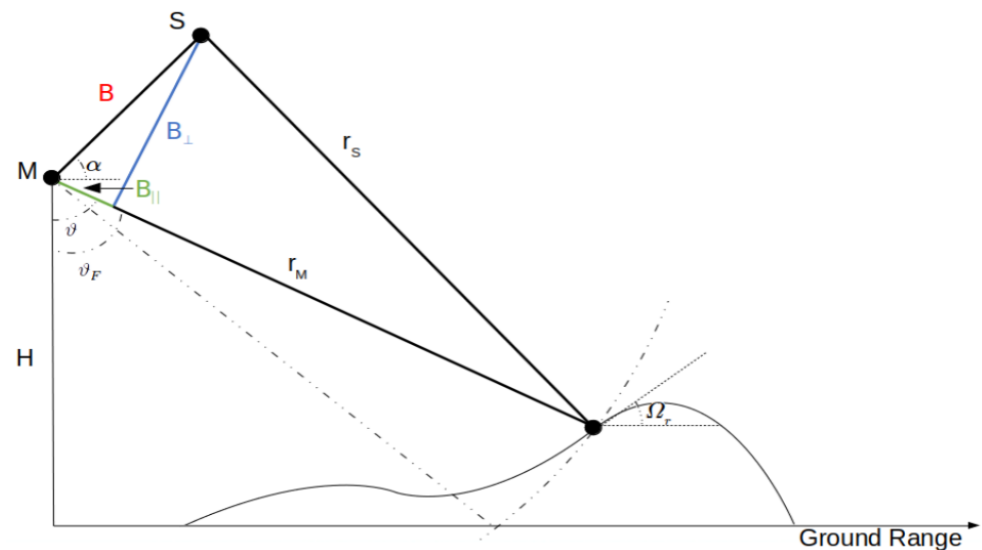
Figure 1. InSAR acquisition geometry (Source: